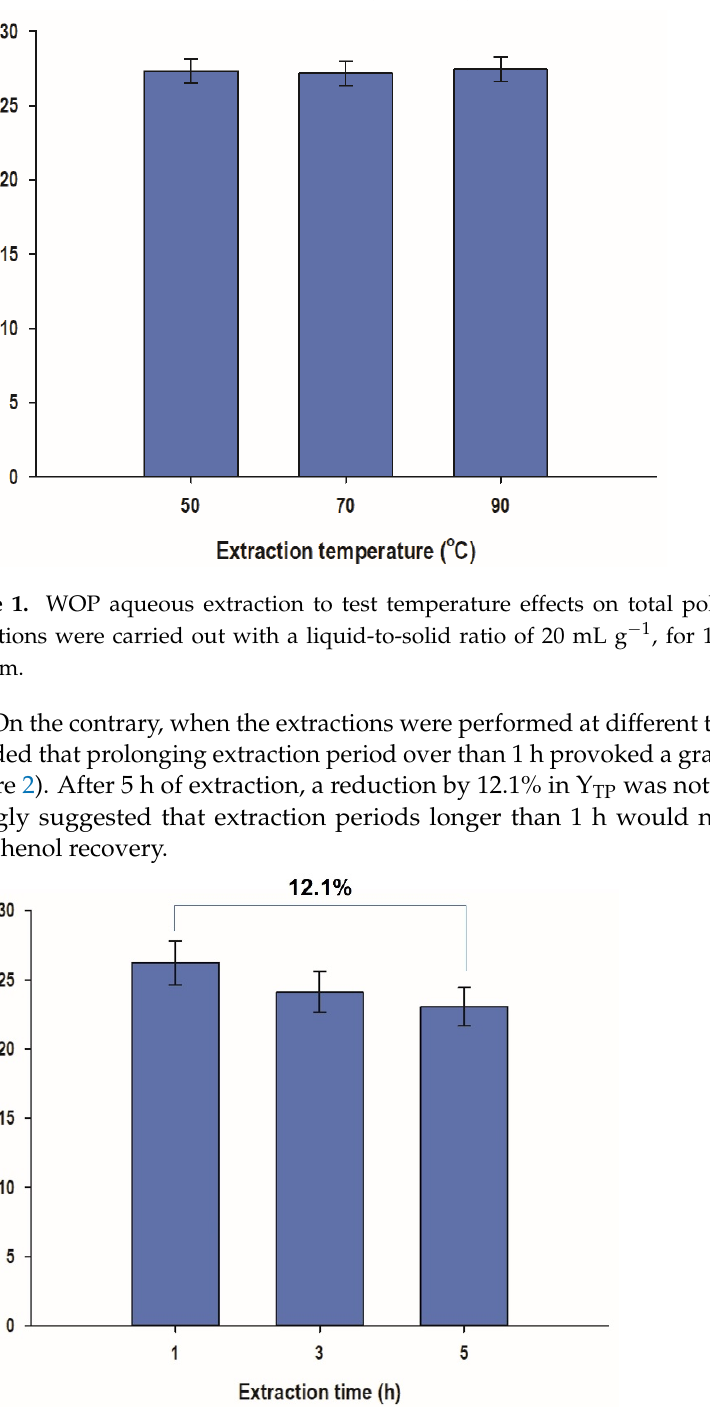
Figure 2. WOP aqueous extraction to test time effects on total polyphenol yield. The extractions were carried out with a liquid ‐ to ‐ solid ratio of 20 mL g − 1 , at 50 °C, under stirring at 500 rpm.